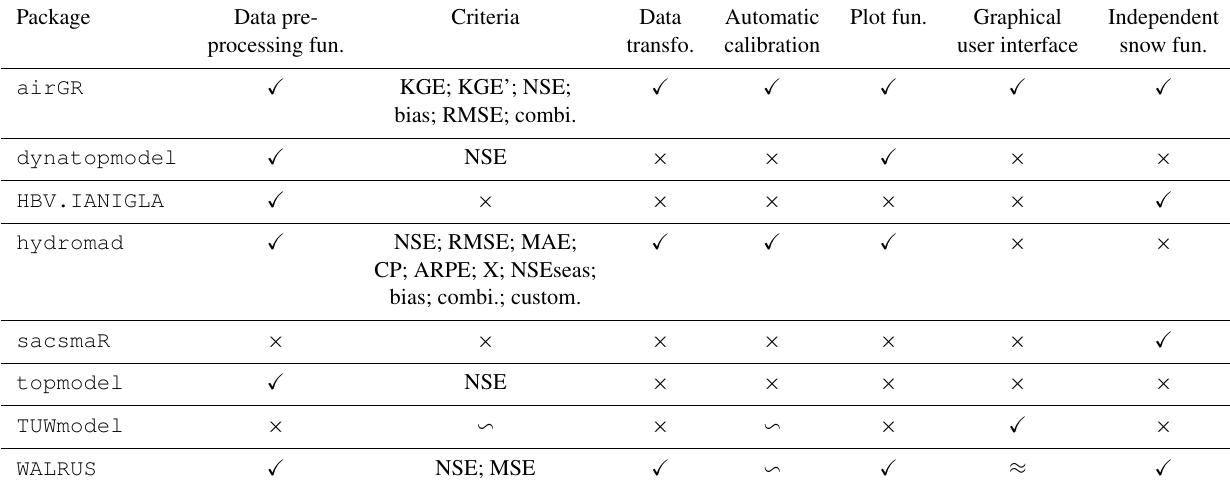
Table 6. Functionalities provided by the packages. Note: (cid:88) – the item is offered by the package; × – not included; ≈ – under development; (cid:118) – suggested in detailed examples or presented in one of the related articles; RMSE – root mean square error; MSE – mean square error; NSE – Nash–Sutcliffe efficiency criterion (Nash and Sutcliffe, 1970); KGE – Kling–Gupta efficiency criterion (Gupta et al., 2009); KGE’ – a modified version of the KGE (Kling et al., 2012); MAE – mean absolute error criterion; CP – coefficient of persistence criterion (Kitanidis and Bras, 1980); ARPE – average relative parameter error criterion (Jakeman et al., 1990); X – correlation of modelled flow with model residuals (Littlewood, 2002); NSEseas – NSE with mean of each month as the reference model instead of the overall mean; combi. – the criterion is a weighted combination of several criteria; custom. – any available criterion can be customised by the user. This table does not aim to provide guidelines for model evaluation. Other R packages can be used to assess model performance (see the explanations below). Package Data pre- Criteria Data Automatic Plot fun. Graphical Independent processing fun. transfo. calibration user interface snow